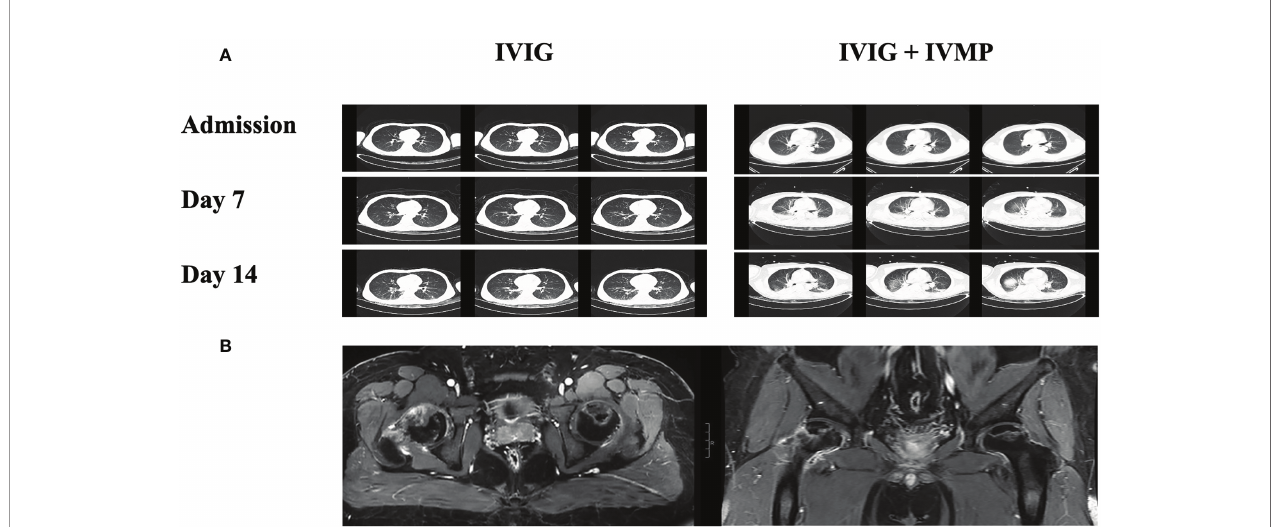
FIGURE 2 | Images of chest CT scan evolution of cases in two groups during treatment and images of steroid-induced necrosis. (A) Images of chest CT scan at admission, 7 and 14 days after immunotherapy from cases in IVIG groups and IVIG + IVMP group. (B) Images of MRI scan of steroid-induced necrosis from case in IVIG + IVMP group.